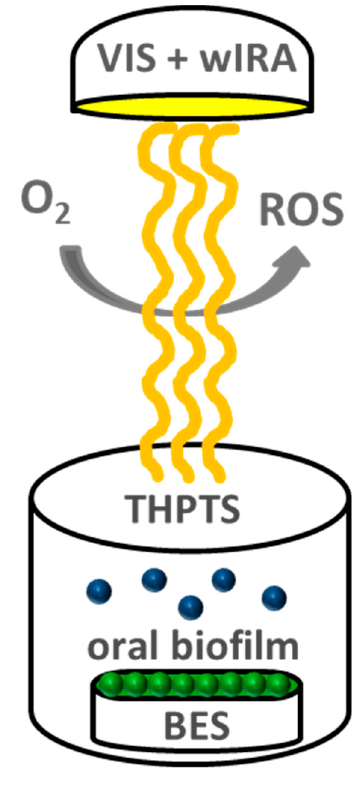
Figure 2. Simplified illustration of the antimicrobial photodynamic therapy (APDT) using visible light plus water-filtered infrared-A (VIS+wIRA). The photosensitizer tested, tetrahydroporphyrin- tetratosylate (THPTS), went to the excited-singlet state after being treated with VIS+wIRA at a wavelength range from 570 nm to 1400 nm. In the presence of oxygen (O2), the excited THPTS stimulated the release of reactive oxygen species (ROS), such as singlet oxygen, which penetrate and eradicate resistant microbial networks such as the oral biofilm.